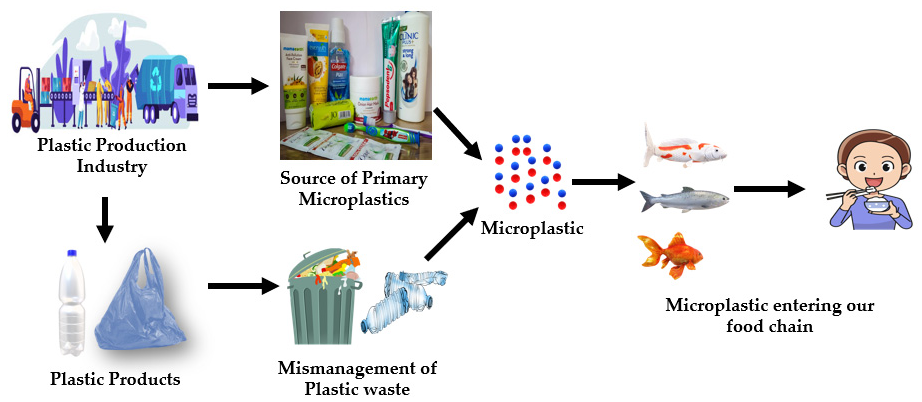
Figure 3. Lifecycle of microplastic: generation to food chain.